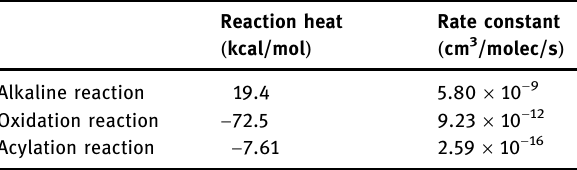
Reaction heat ( kcal/mol )